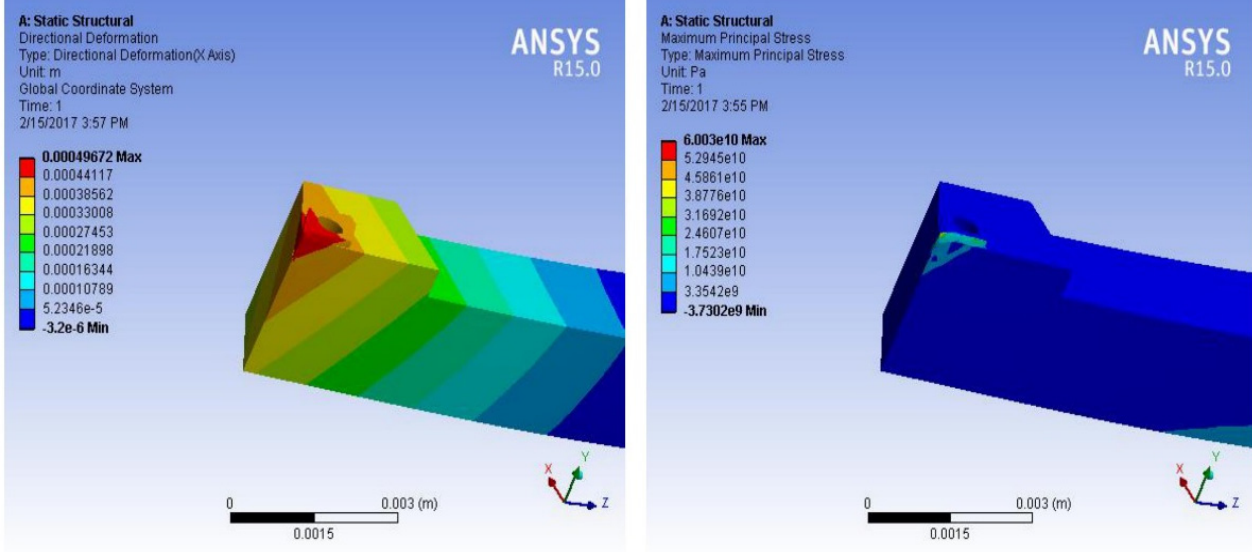
Figure 4. Stress distribution and deformation of tool holder in turning tests.